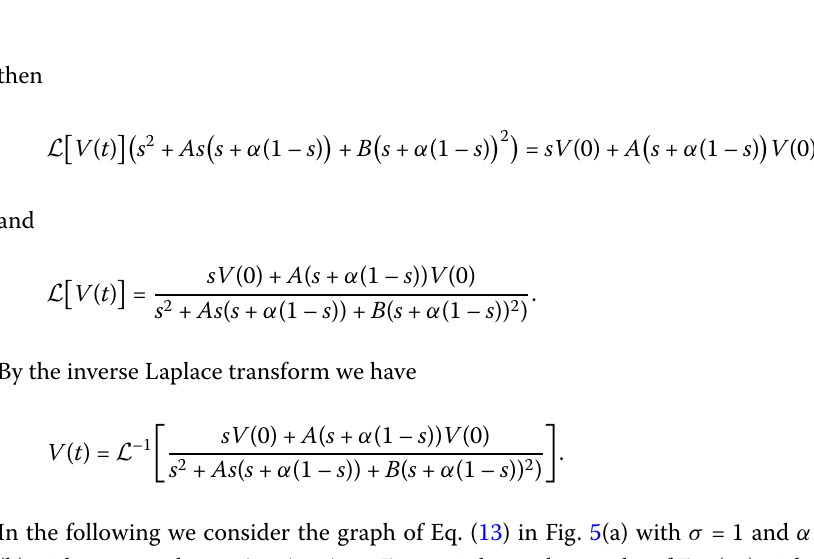
Figure 5 Graphs of Eq. (13) with L = 7 H, R = 6 (cid:4) , C = 1